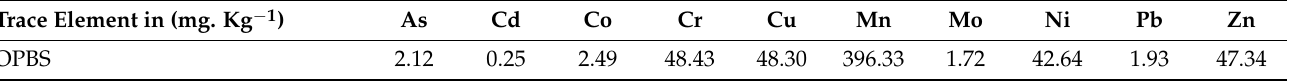
Table 3. Trace element composition in OPBS.